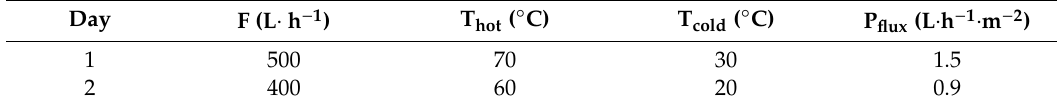
Table 3. Permeate production with the operating conditions of the cases shown in Figure